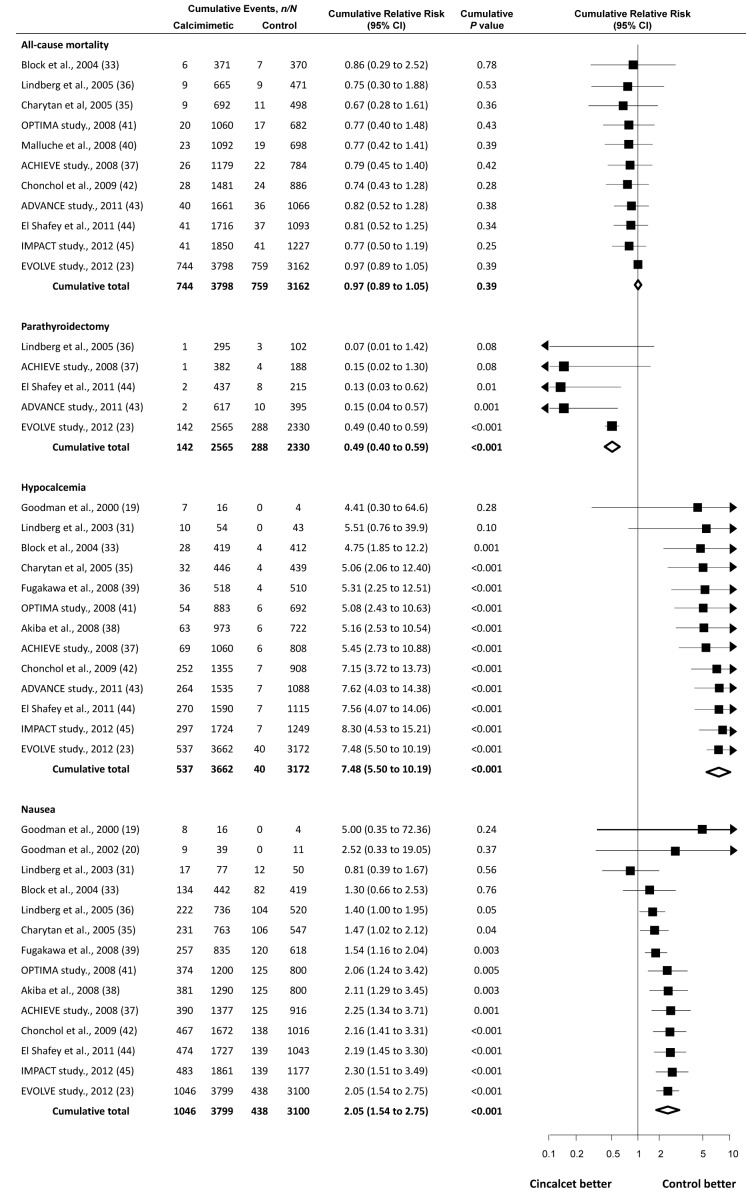
Cumulative meta-analysis of randomized trials comparing cinacalcet plus conventional therapy versus placebo or no treatment plus conventional therapy.Studies are listed by first author or study name, year, and reference number (in parentheses).